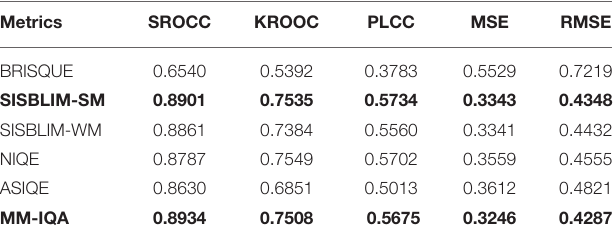
TABLE 3 | Performance comparison of RR-IQA metrics on the pool image